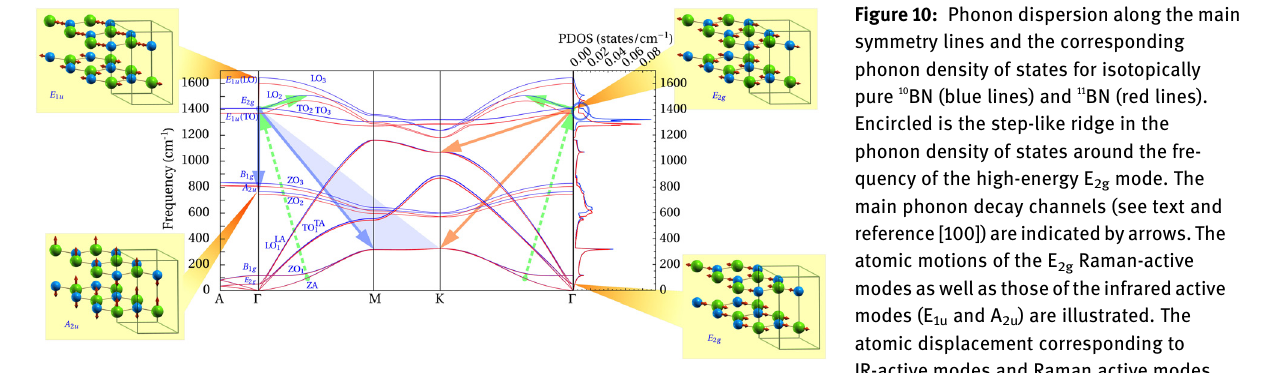
Figure 10: Phonon dispersion along the main symmetry lines and the corresponding phonon density of states for isotopically pure 10 BN (blue lines) and 11 BN (red